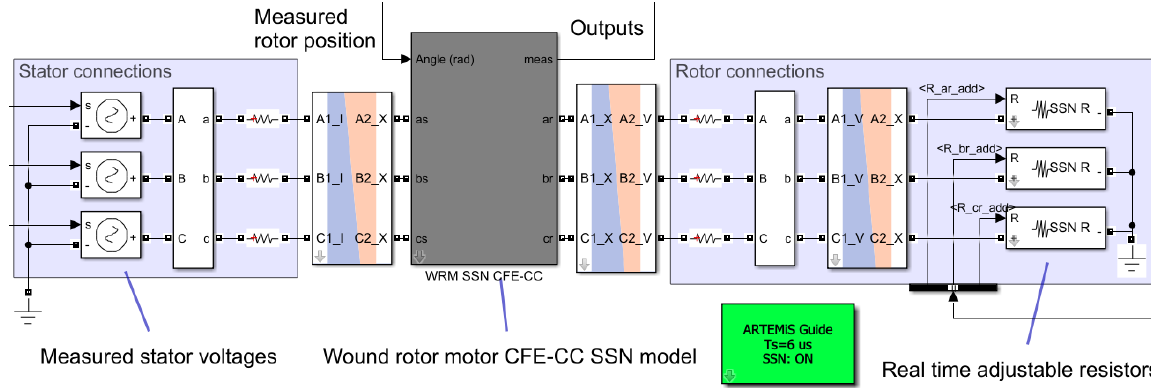
Figure 5. Real-time digital twin (RTDT) implementation overview in Simulink using ARTEMIS